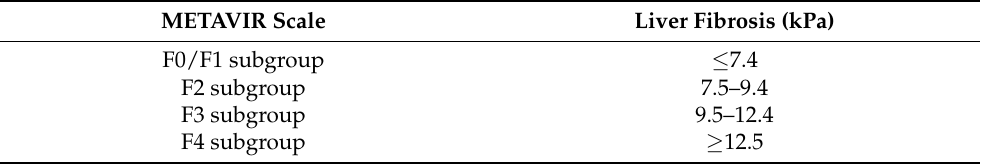
Table 1. Distribution of patients in subgroups according to the baseline fibrotic